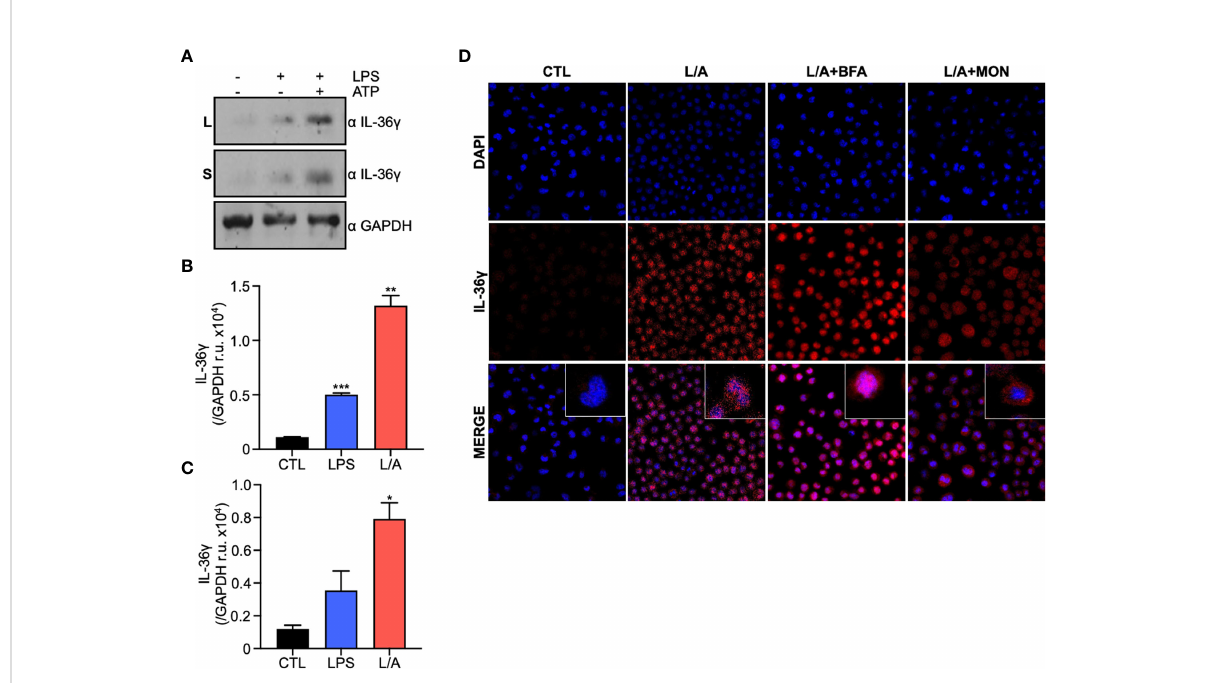
FIGURE 1 IL-36 g is secreted in response to ATP in a non-conventional pathway. (A) IL-36 g protein expression in lysates (L) and supernatants (S) of LPS or LPS/ATP activated macrophages. Densitometry of IL-36 g intensity in lysates (B) and supernatants (C) of cell stimulated with LPS or LPS/ATP (L/ A). (D) IF of IC21 macrophages stimulated with LPS/ATP (L/A) and treated with monensin (Mon) or brefeldin A (BfA). *p<0.05, **p<0.01,